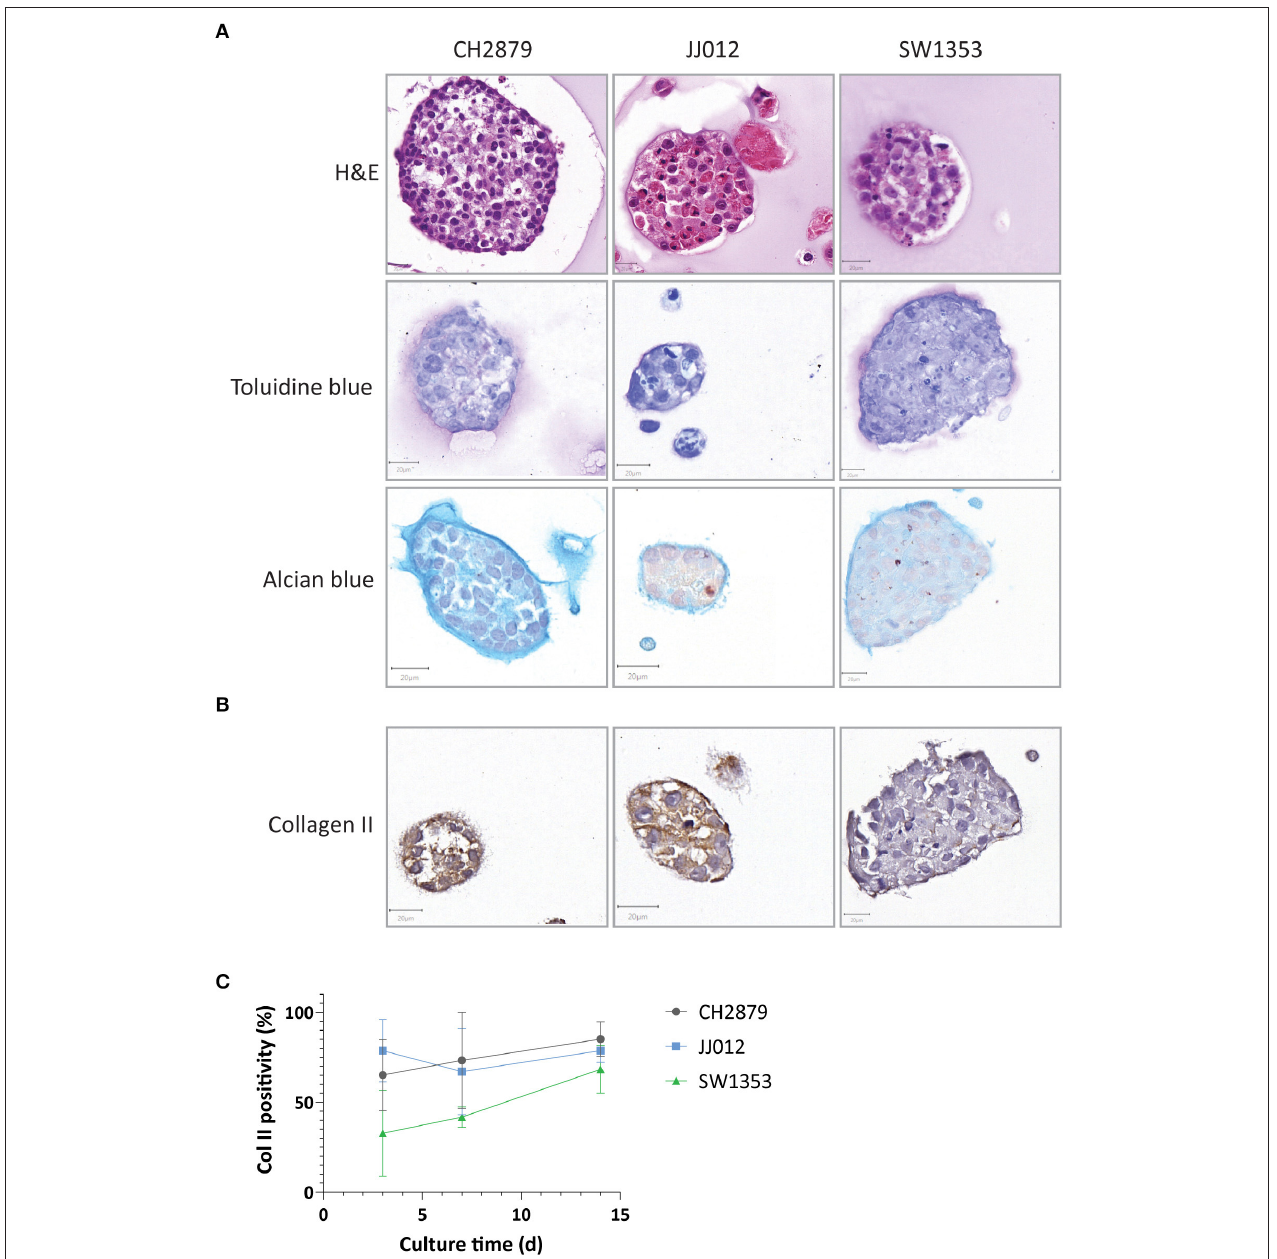
FIGURE 1 | Chondrosarcoma 14 day alginate spheroid cultures were assessed for (A) Spheroids presented chondrosarcoma-like histology (as seen by HandE) and were positive for chondrosarcoma extracellular matrix components such as glycosaminoglycans (toluidine and alcian blue staining) (B) Collagen II expression was present in all three cell lines and (C) expression levels remained stable or increased over time ( n ≥ 3). Scale bar = 20 µ